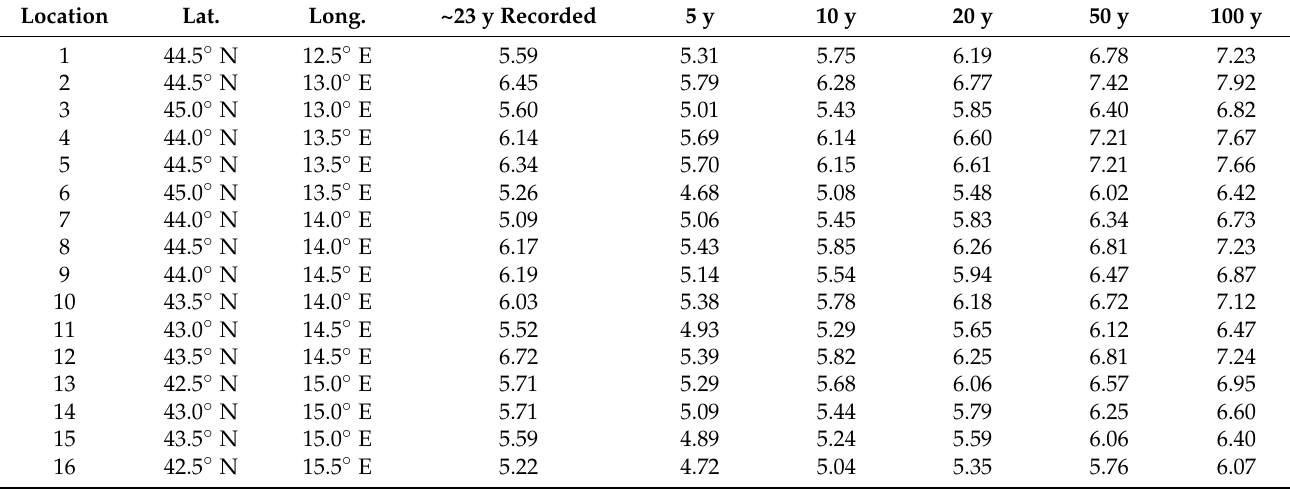
Table A12. Most probable extreme significant wave heights, Hs RP (m), for various return periods. Location